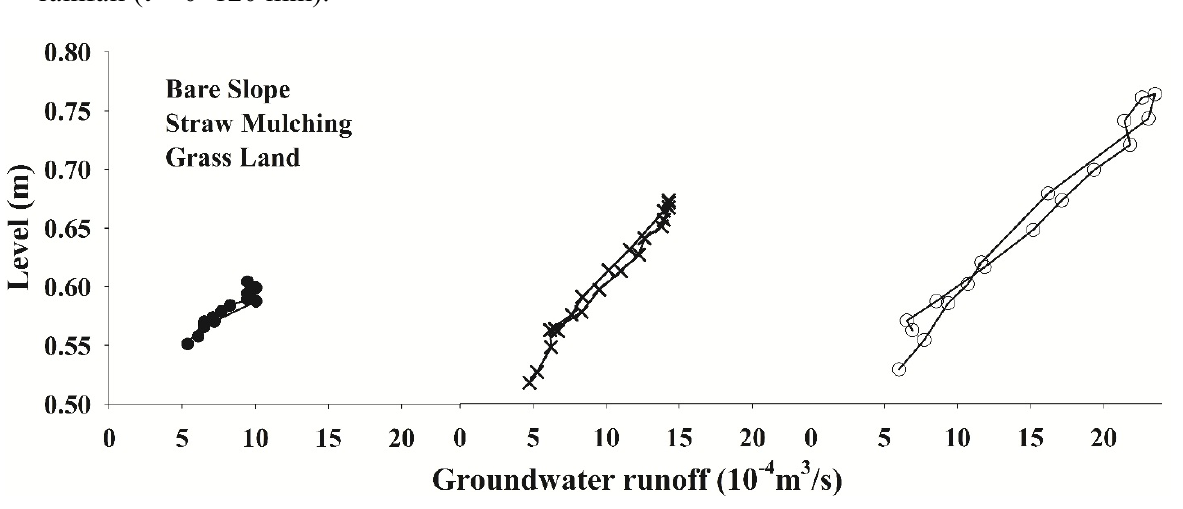
Figure 19. Stage–discharge relationship of the groundwater for three scenarios during rainfall (t = 0–120